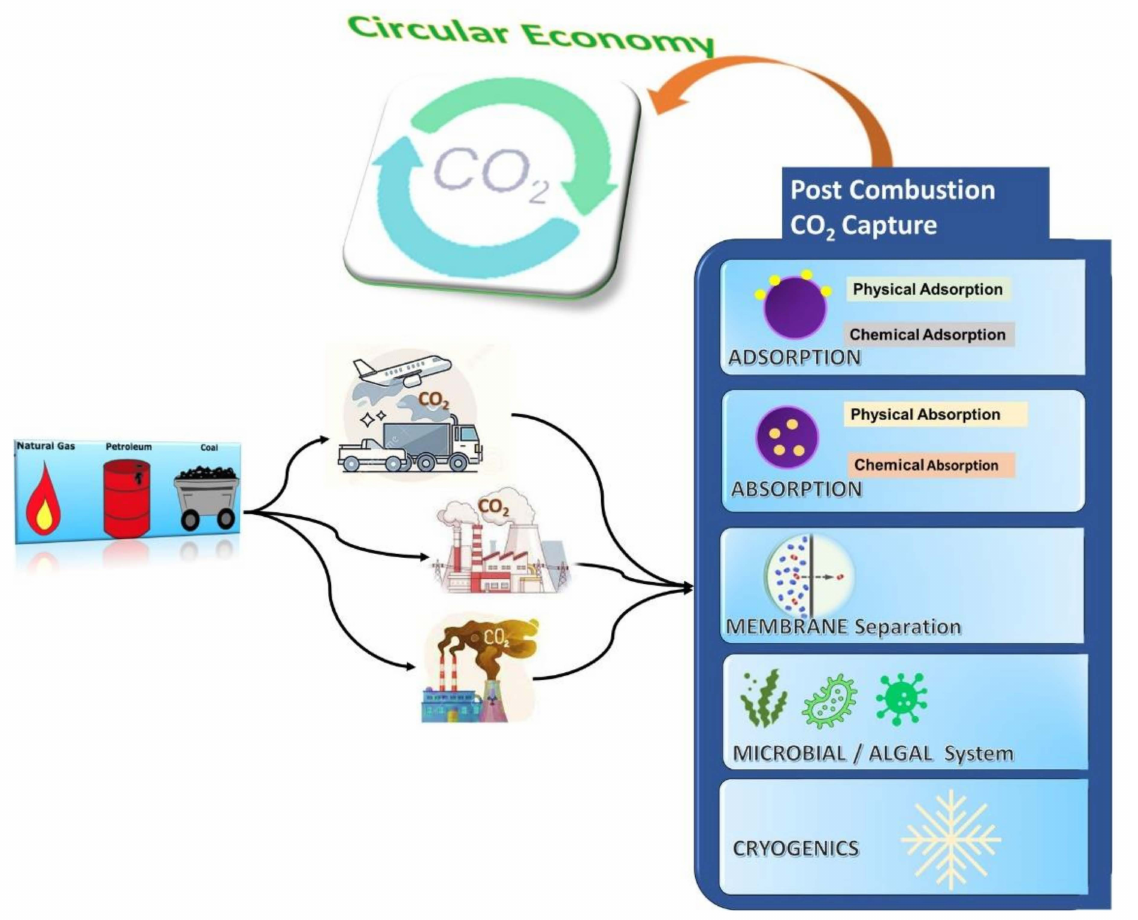
Figure 2. Scheme summarizes the main topics